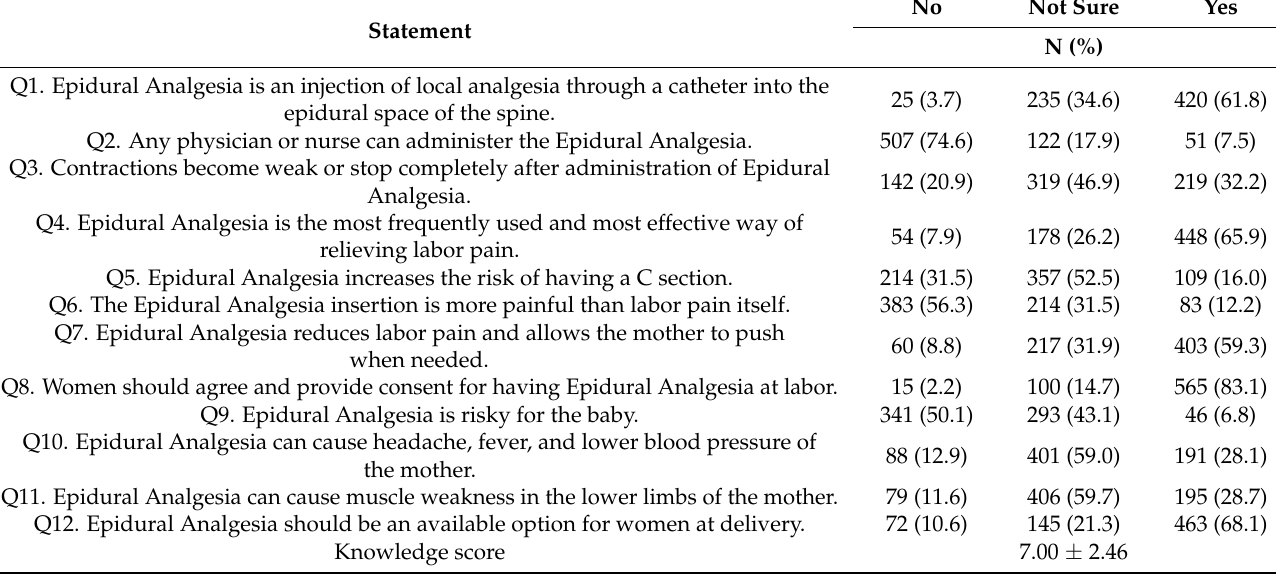
Table 2. Response to knowledge questions for the whole